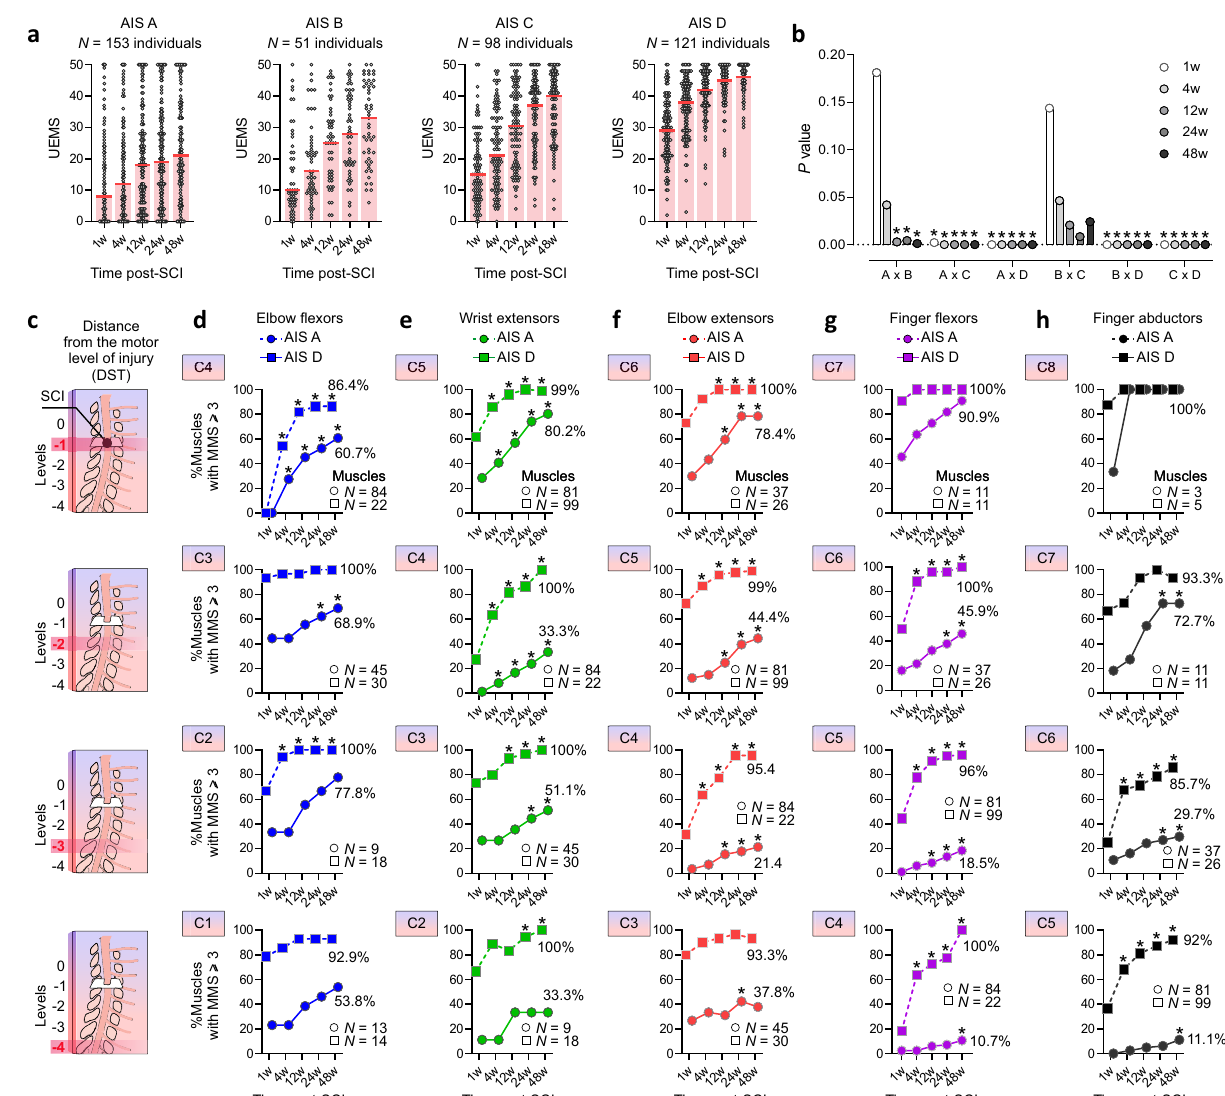
Fig.3|StrengthrecoveryinupperlimbmusclesaftercervicalSCI.a Themedian UEMS in AIS A-D indicates some recovery independent of the SCI severity. While UEMS at onset are similar in AIS A and AIS B at 1w – 4w post-SCI the extent of recovery at 12w – 48w is higher in AIS B. AIS C and D show different UEMS at onset and over time. b Statistical comparisons for the UEMS data in ( a ). c The distance between the motor level and the myotome (DST) was controlled in D – H. d – h In individuals classi fi ed as AIS A, the probability of the proximal muscles (i.e., elbow fl exors, wrist extensors, and elbow extensors) achieving against gravity